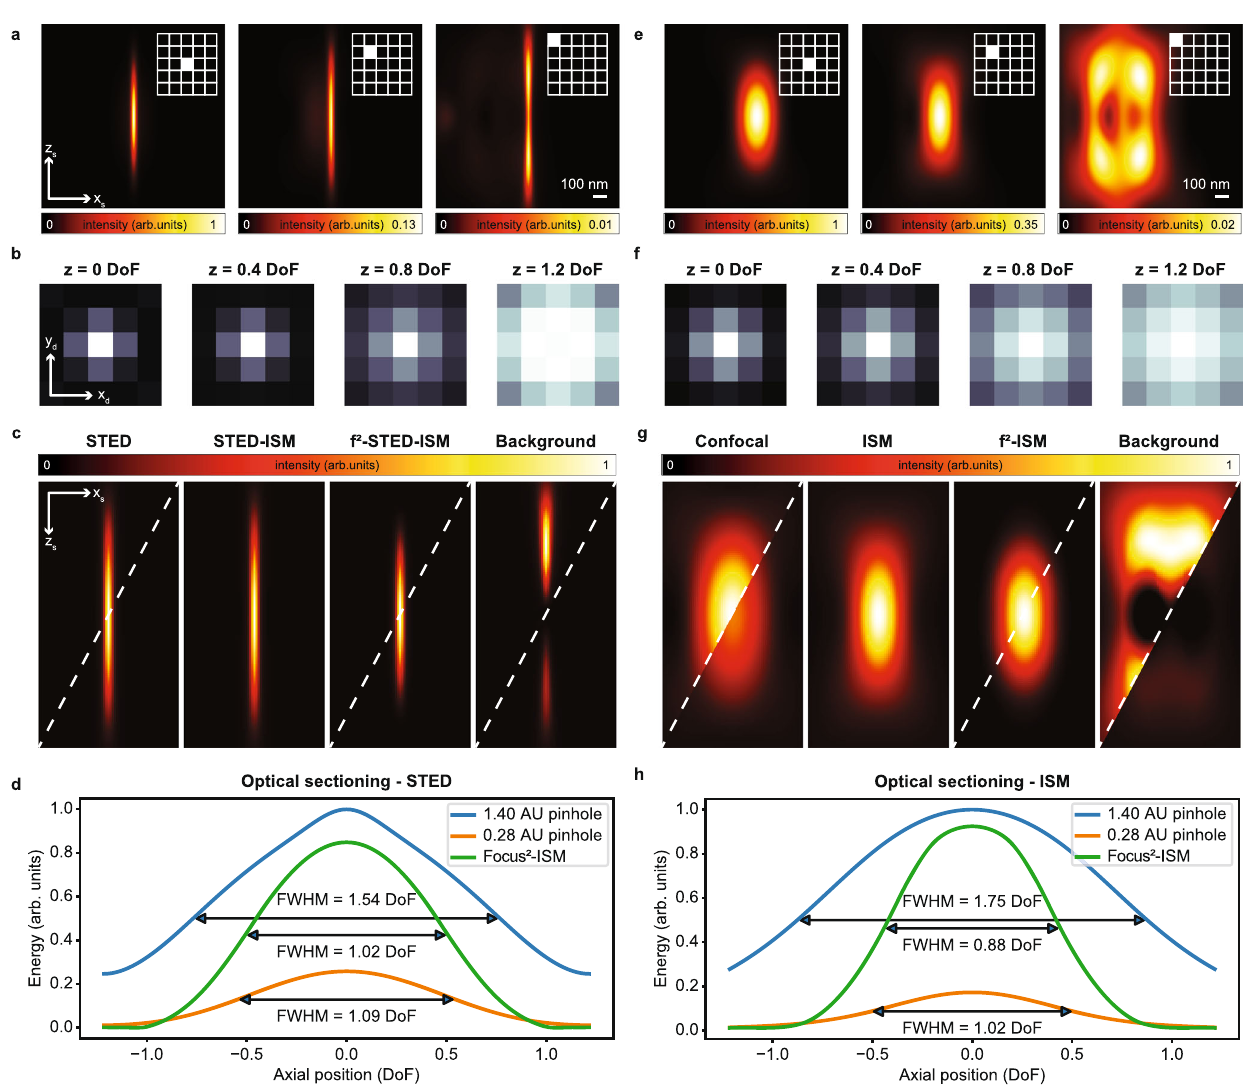
Fig. 4 | Focus-ISM principle. In ( a ), we show STED PSFs ( ς =300) related to the detector element highlighted with the white box. The z , r images are obtained by sectioning the 3D PSFs along the main diagonal. In ( b ), we show the fi ngerprint at different axial positions, calculated by summing all the scan points from the cor- responding sections of the STED PSF. In c , we show the reconstructed STED PSFs. From left to right: raw STED (open pinhole), STED-ISM, focus-ISM, and removed background. In ( d ), we show the energy of each axial plane of the simulated STED PSFs,obtainedbyintegratingthevolumesalongthe x s and y s dimensions.In( e ),we show the (normalized) confocal PSFs corresponding to the detector element highlighted with the white box. In ( f ), we show the fi ngerprint at different axial